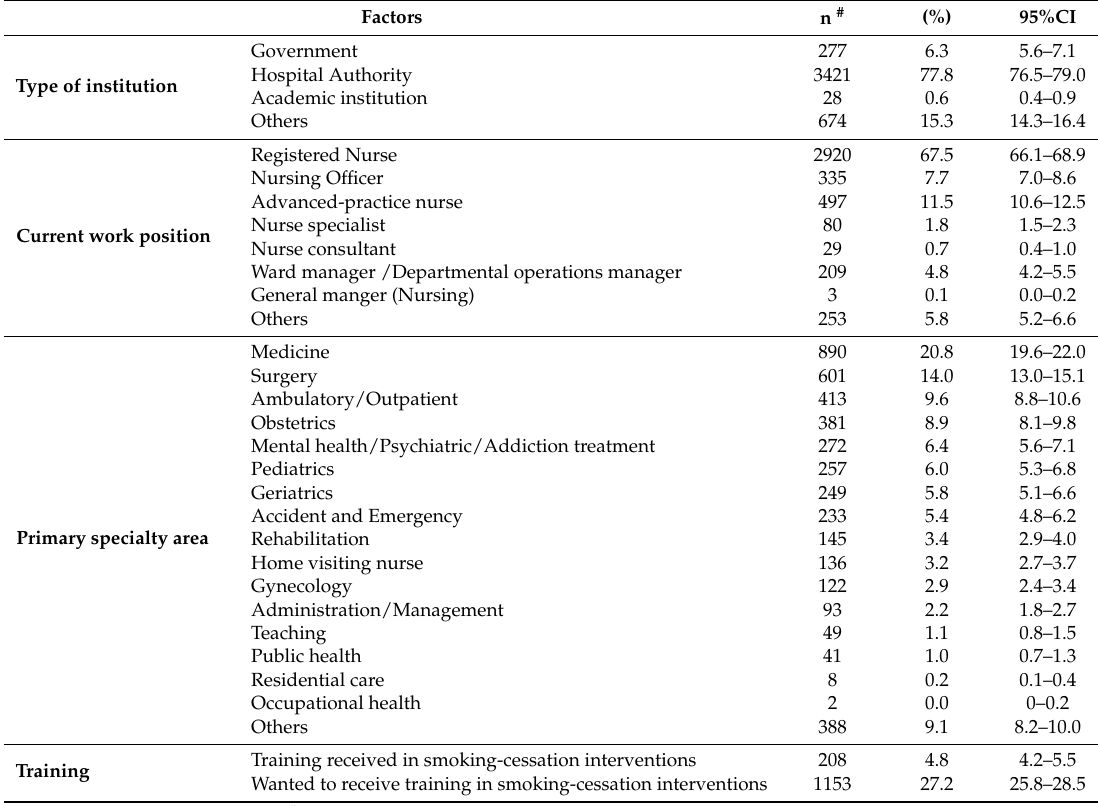
Types of work settings, position, primary specialty area, and training relating to smoking-cessation interventions (N =